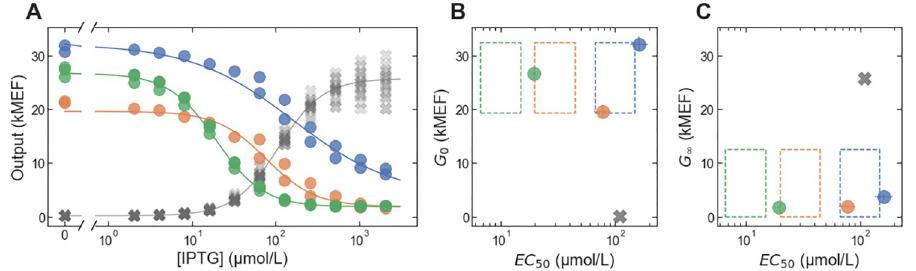
Fig 4. Multi-objective in silico selection of inverted LacI variants. (A) Dose-response curves for LacI variants selected to have inverted dose-response curves with specified EC 50 . One variant is plotted for each target specification, each with a different color and with lines showing the fits to the dose-response using the Hill equation. The wild-type dose response is plotted with the gray ‘X’ markers. (B-C) Evaluation of multi-objective selection performance. The dashed rectangles show the target specifications in a 2D plot of G 0 (B) and G 1 (C) vs. EC 50 , each with a different color. For each specification, one LacI variant was selected, and the resulting G 0 , G 1 and EC 50 values (from cytometry) for those variants are plotted (with marker color indicating the targeted specification). For comparison, the wild-type G 0 , G 1 and EC 50 are plotted with gray ‘X’ markers. Error bars indicate ± one standard deviation and are typically smaller than the